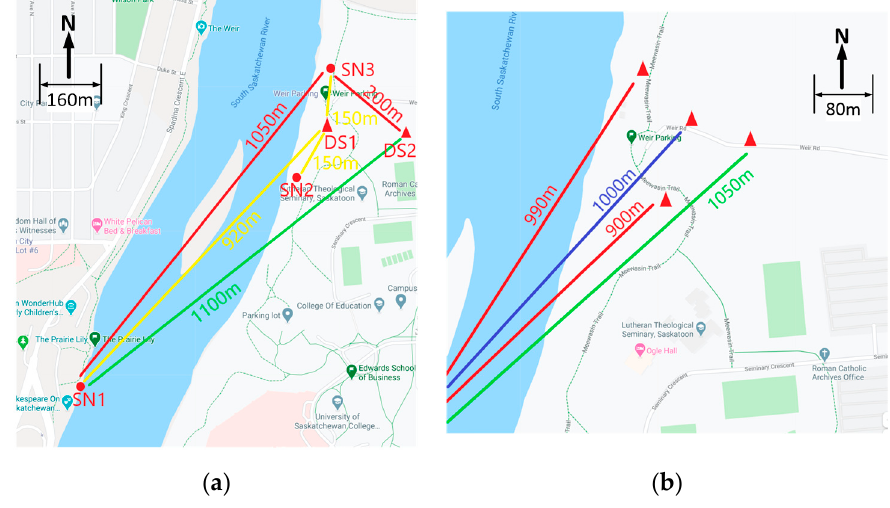
Figure 9. Google Map view of ( a ) WQM field trial setup of Sensor Nodes SN1, SN2, SN3, and Data Sinks DS1, DS2, DS3; ( b ) different positions of the mobile data sinks.